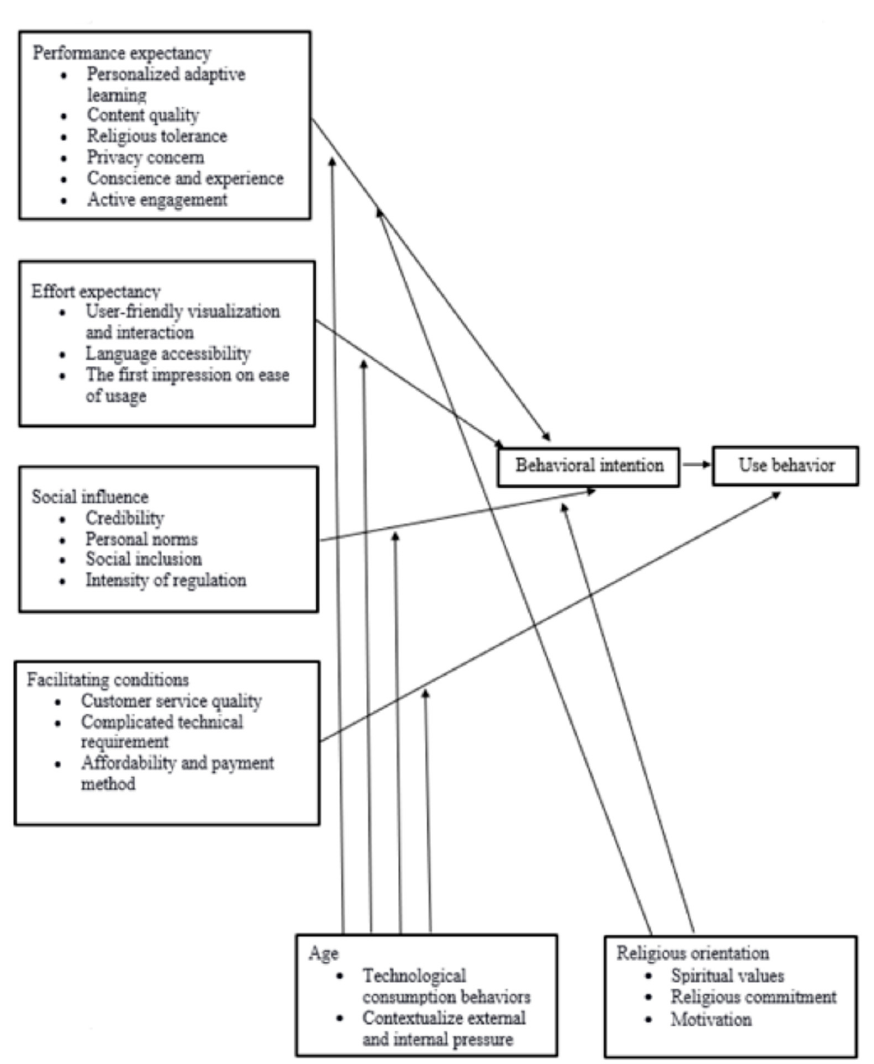
Figure 1. The theoretical model developed based on the coded data, adapted from the Unified Theory of Acceptance and Use of Technology (UTAUT) model.